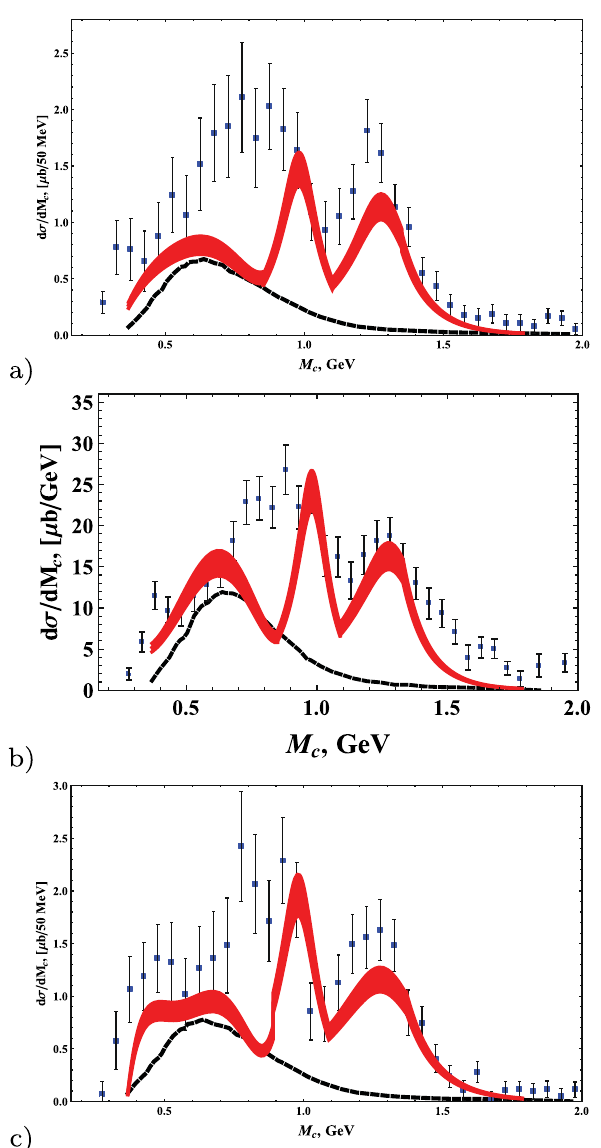
Fig. 11 Data on the process p + p → p + π + + π − + p (CMS √ s = 5 TeV with cuts | η π | < 2 . 4, p T ,π > collaboration [29,30]): a at √ s = 7 TeV with cuts | y π | < 2, p T ,π > 0 . 2 GeV; 0 . 2 GeV; b at √ c at s = 13 TeV with cuts | η π | < 2 . 4, p T ,π > 0 . 2 GeV. Curves correspond to Λ π = 1 . 2 GeV in the off-shell pion form factor (11) and couplings from (14). Solid upper curves correspond to the sum of all amplitudes, and dashed lower curves represent the continuum contribution. The thickness of the solid curves corresponds to the errors ofMonteCarlocalculations.Additionalinterpolationwasusedbetween calculated points for